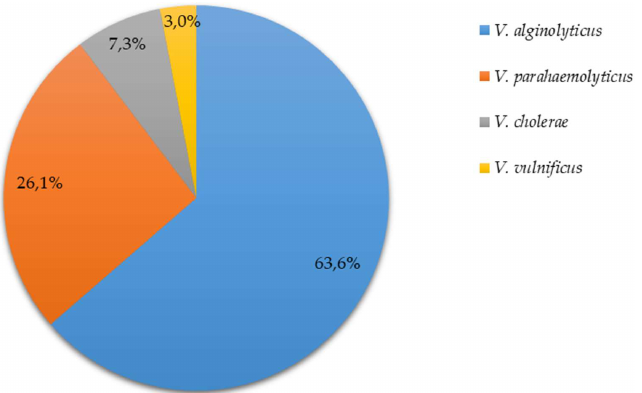
Figure 2. Pie graph depicting the percentage of contaminated samples that tested positive for V. parahaemolyticus , V. cholerae , V. vulnificus , and V. alginolyticus